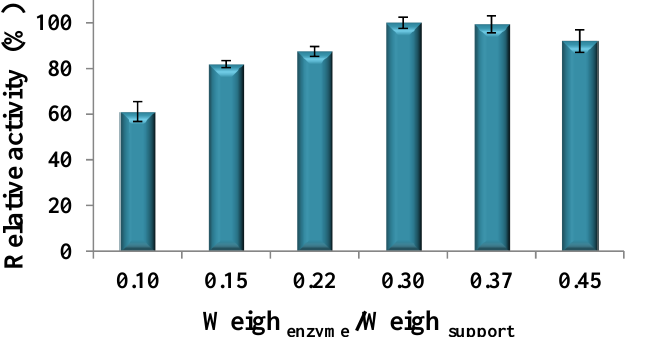
Figure 1. Relative activity (%) as a function of enzyme/support ratio during immobilization of the BCL on biochar by CB.